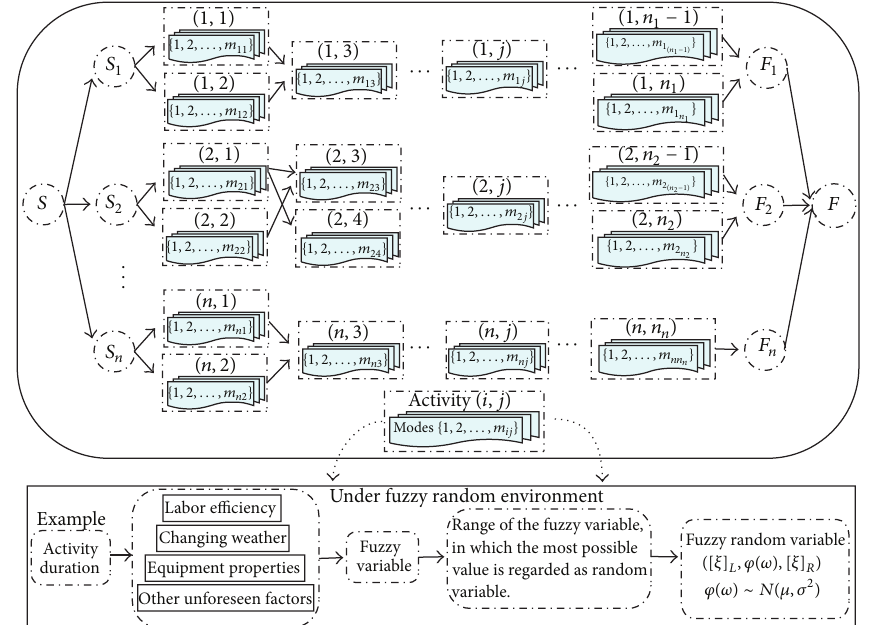
Figure 1: Problem description for